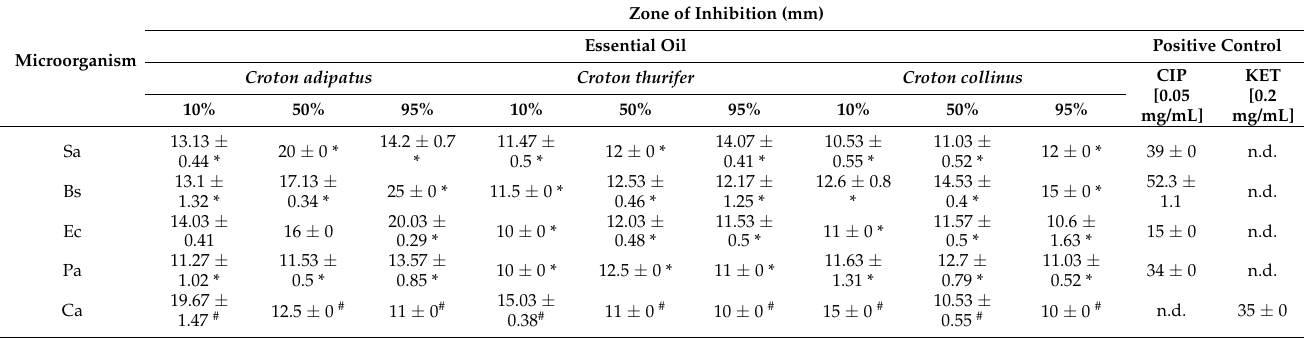
Table 2. Comparative table of the antimicrobial activity of essential oils and standards by the agar diffusion method.